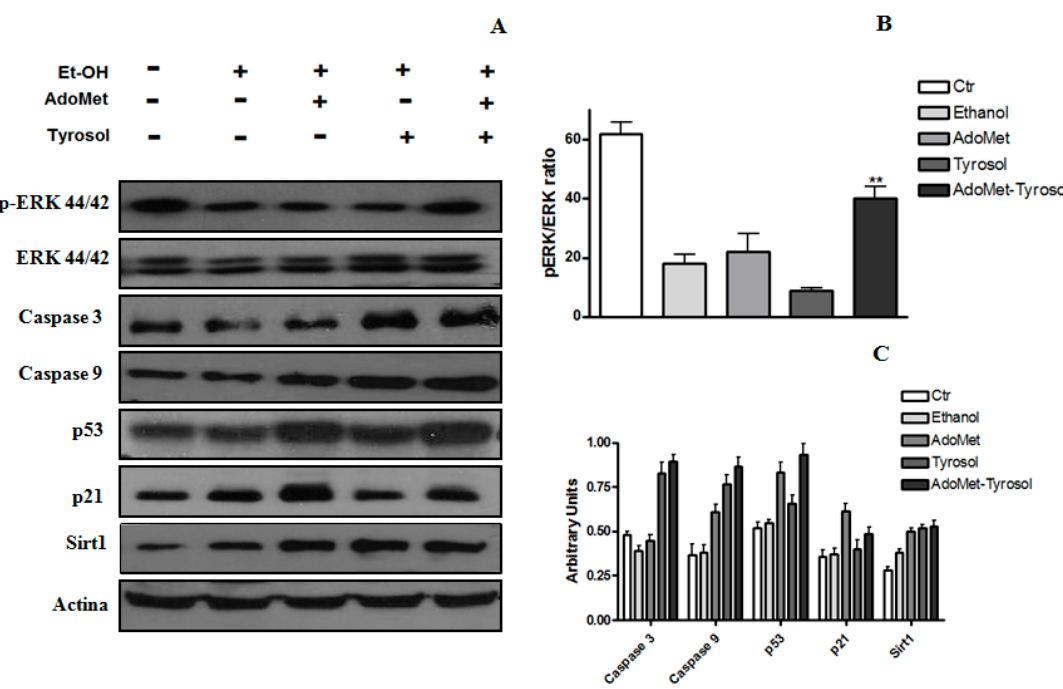
Figure 3. Effect of AdoMet, Tyr, and their combination on protein expression in HepG2 cells after acute ethanol treatment. The expression in cell lysates of SIRT1, Erk, p-Erk, caspase 3, caspase 9, p53, p21, and SIRT1 was assessed by Western-blot analysis using β -actin as an internal control ( A ); Densitometric quantitation of pERK/ERK ratio in different conditions ( B ); Densitometric quantification of SIRT1, caspase 3, caspase 9, p53, and p21 ( C ). Values represent the mean ± SD of three experiments. ** p < 0.01 was considered significant for ethanol alone.